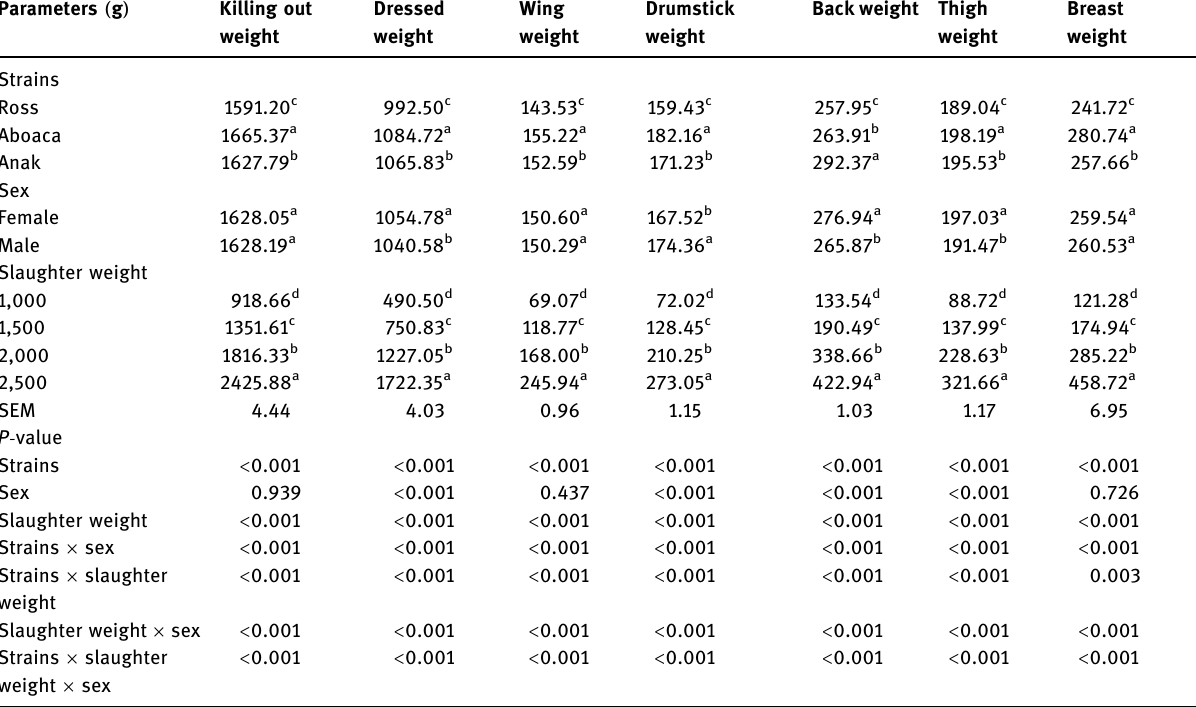
Table 3: Strain, sex and slaughter weight e ff ect on carcass characteristic of three commercial broiler chickens Parameters ( g